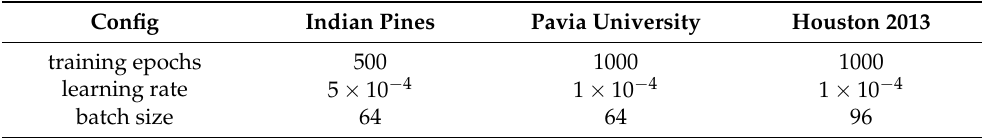
Table 1. The details of experimental settings for the three HSI